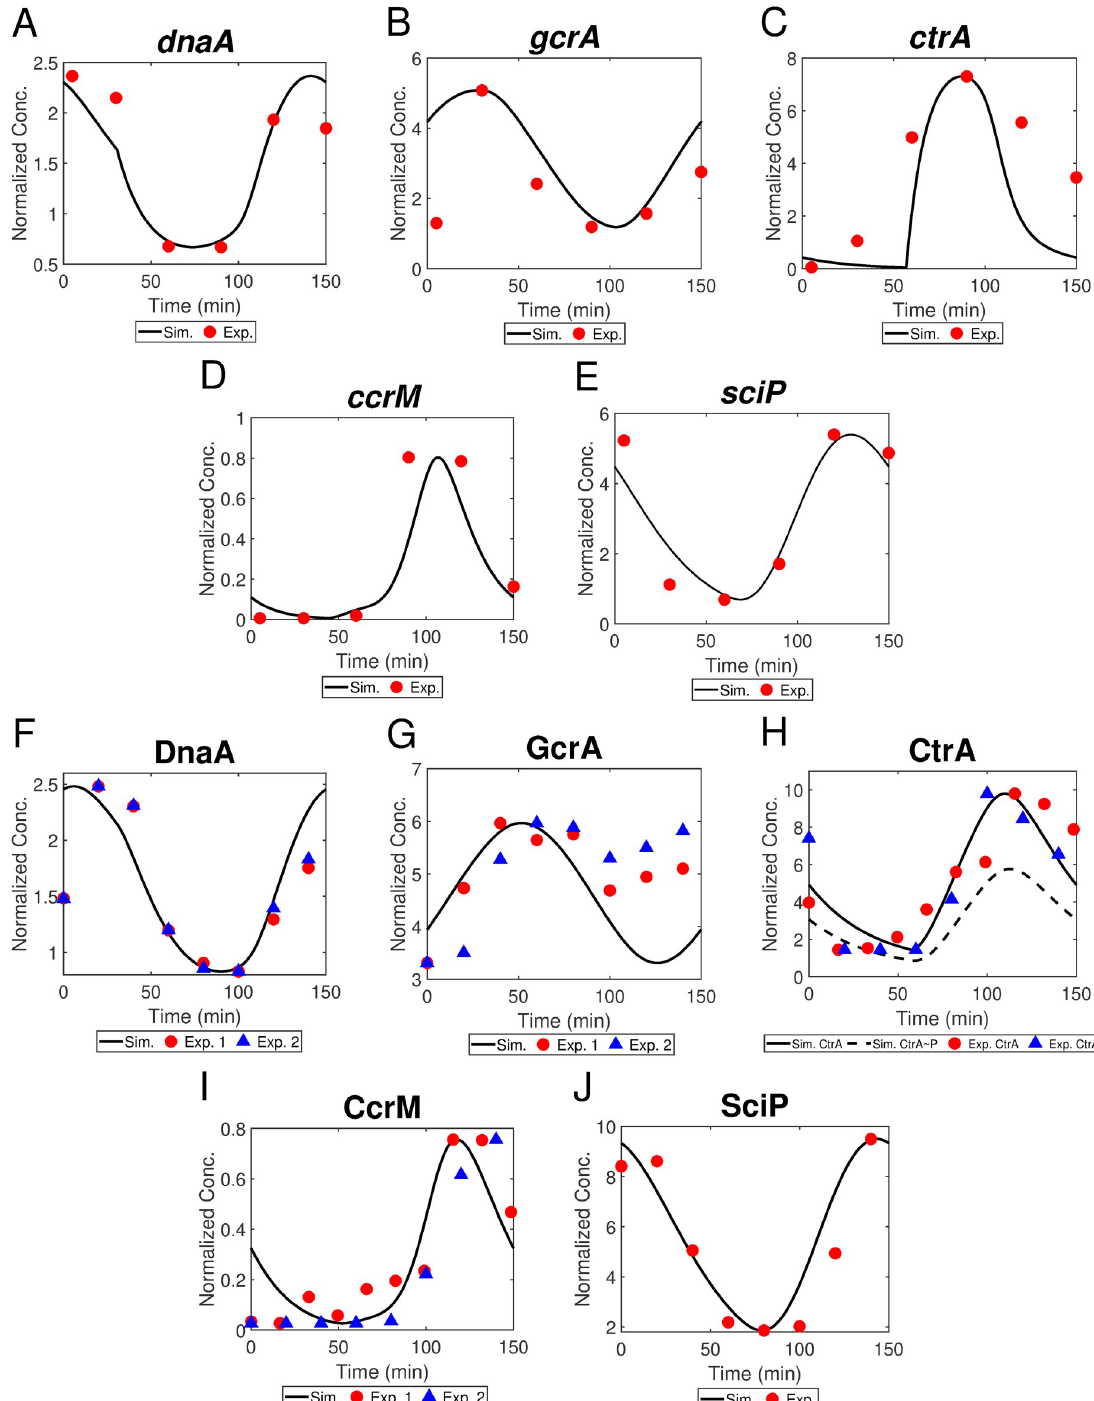
Fig 10. (A-E) Experimental mRNA concentration of dnaA , gcrA , ctrA , ccrM , sciP (curves) with corresponding simulated data (red circles, from Schrader et al. [12]), and (F-J) simulated protein concentration of DnaA, GcrA, total CtrA (CtrA * P), CcrM, SciP (curves) with experimental data (circles or triangles) over a single cell cycle. For the sources of experimental data, DnaA data is from Shen et al. [47] and Collier et al. [7]; GcrA data is from Collier et al. [7] and Tan et al. [2]; CtrA data and CcrM data are both from Reisenauer et al. [48] and Shen et al. [47]; and SciP data is from Tan et al. [2].